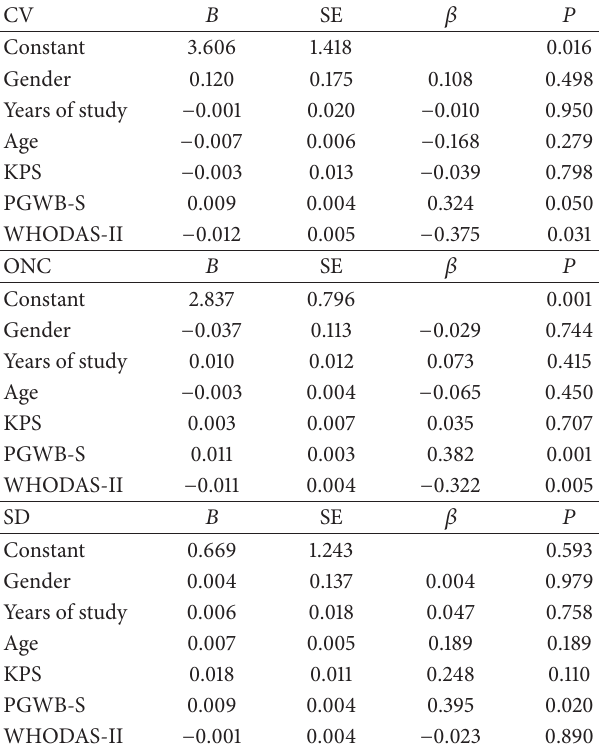
Table 7: Relationship between gender, years of study, age, KPS, diagnosis, PGWB-S, WHODAS-II, and EUROHIS-QoL in CV, ONC, and SD